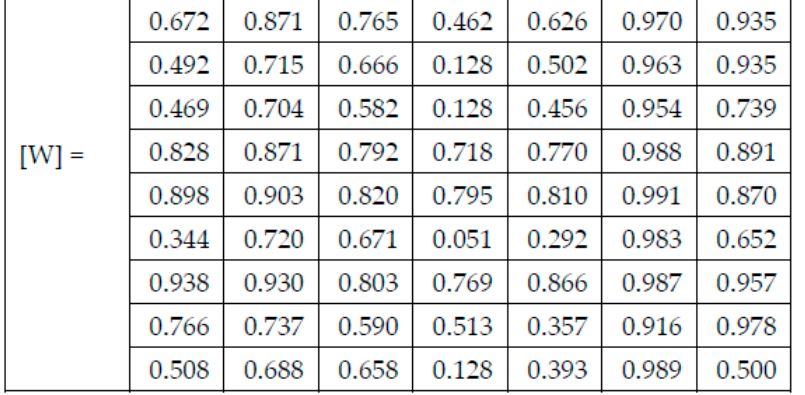
Table 3. The performances obtained for the singular networks.